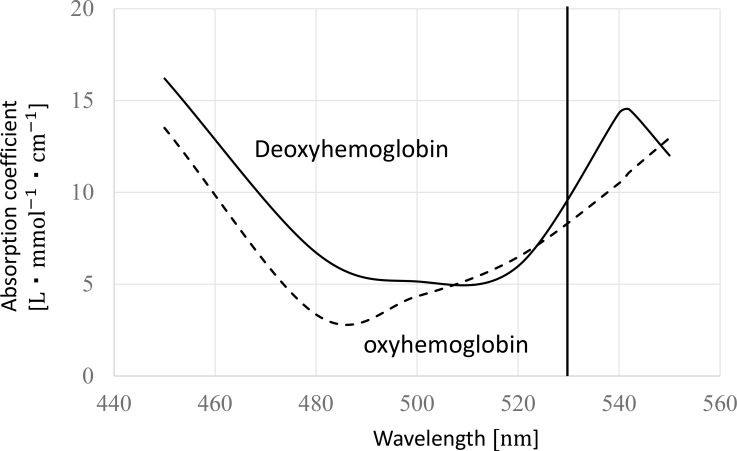
Photo absorption coefficient of oxyhemoglobin and deoxyhemoglobin.